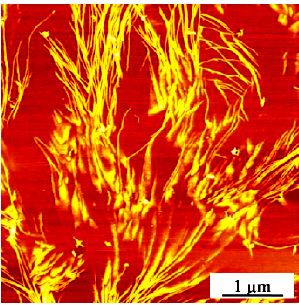
Figure 7. Lamellar twisting of poly( R -3-hydroxybutyrate- co -17 mol% R -3-hydroxyhexanoate) in a thick film with thickness about 10 μ m. Adapted with permission from Ref. [15]. Copyright (2010) American Chemical Society.